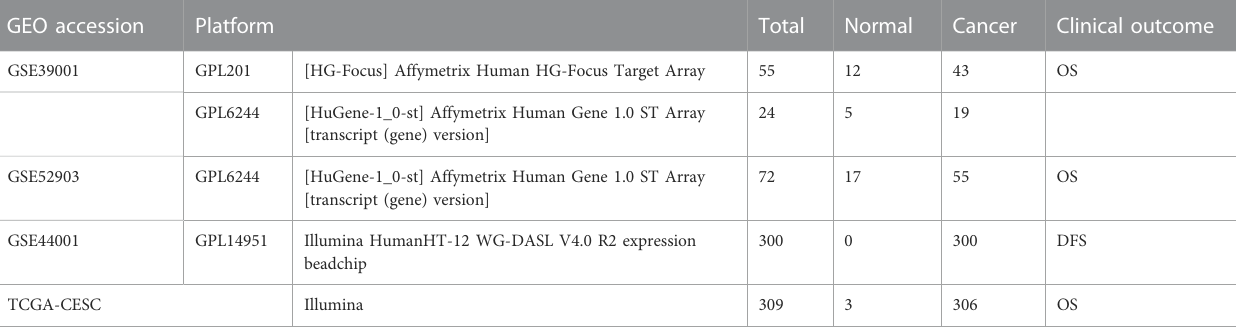
OS, overall survival and DFS, disease-free